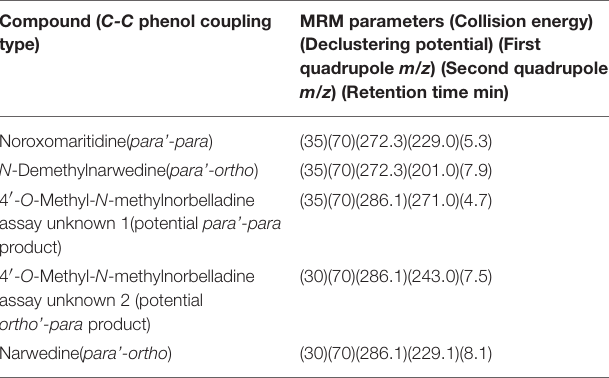
TABLE 3 | MS/MS parameters used in MRM